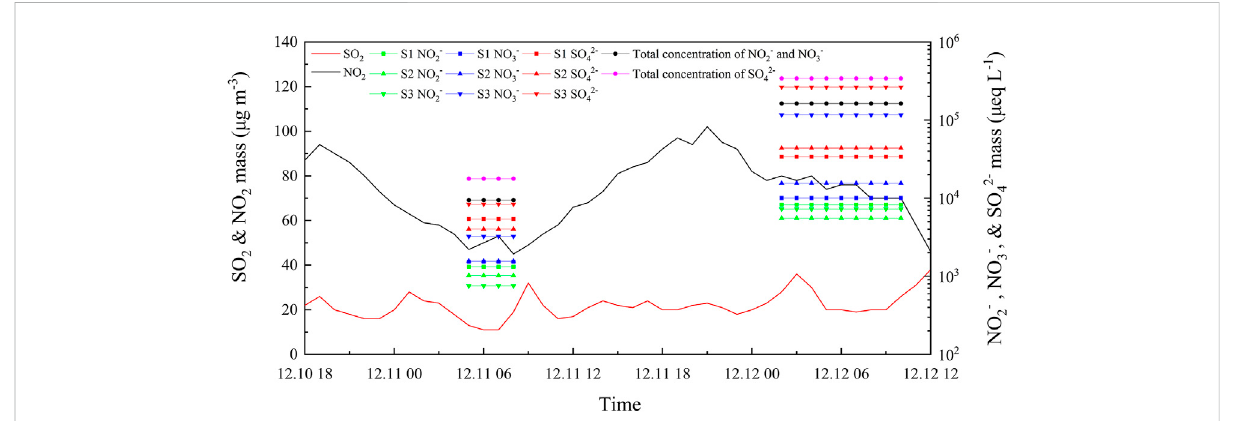
FIGURE 7 Time series of mass concentration of SO 2 and NO 2 in the atmosphere and SO 4 2- , NO 3 − , and NO 2 − in fog water during the two persistent fog cases. The S1, S2, and S3 represent the sample for the large droplets of diameter larger than 22 μ m, medium droplets of diameter within 16 – 22 μ m, and small droplets of diameter within 4 – 16 μ m,